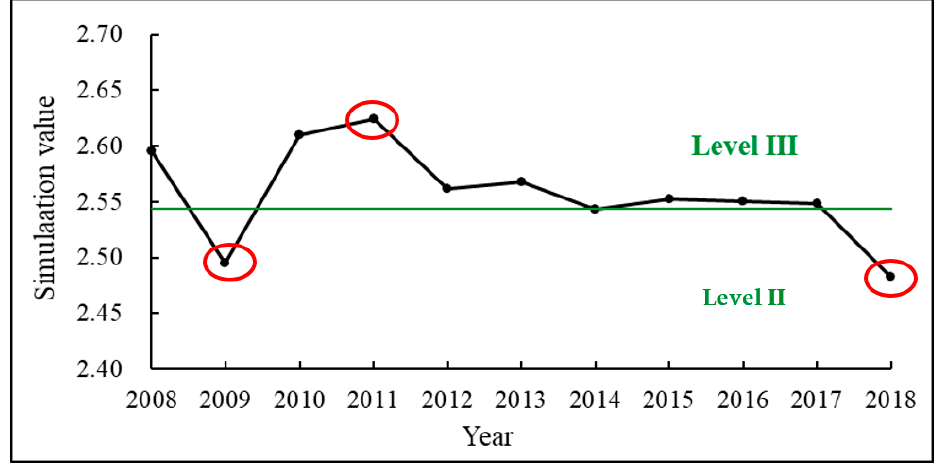
Figure 3. The temporal variation curve of AWLRSV based on SOA-RF in Heilongjiang Province from 2008 to 2018.